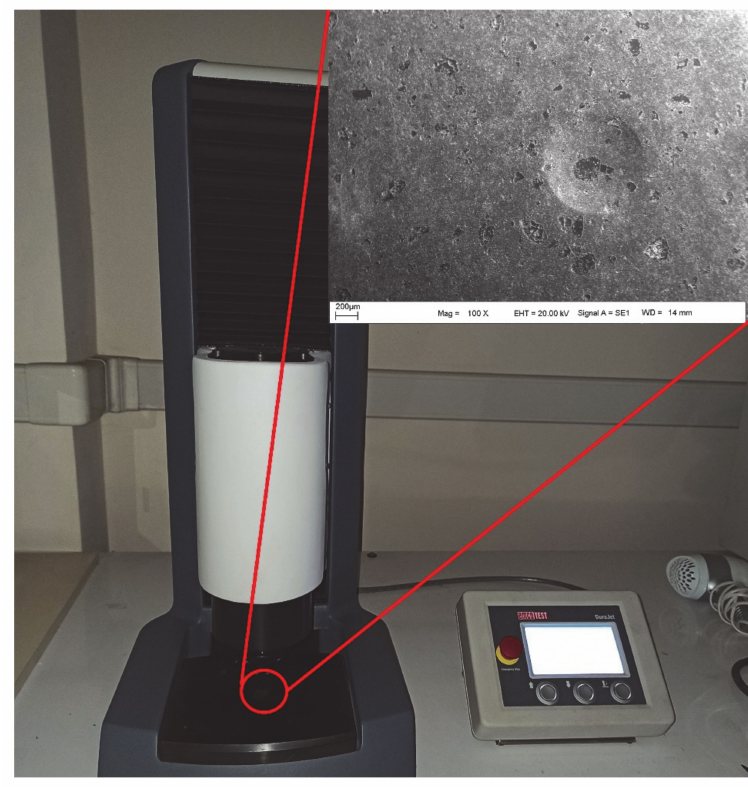
Figure 3. Brinell hardness